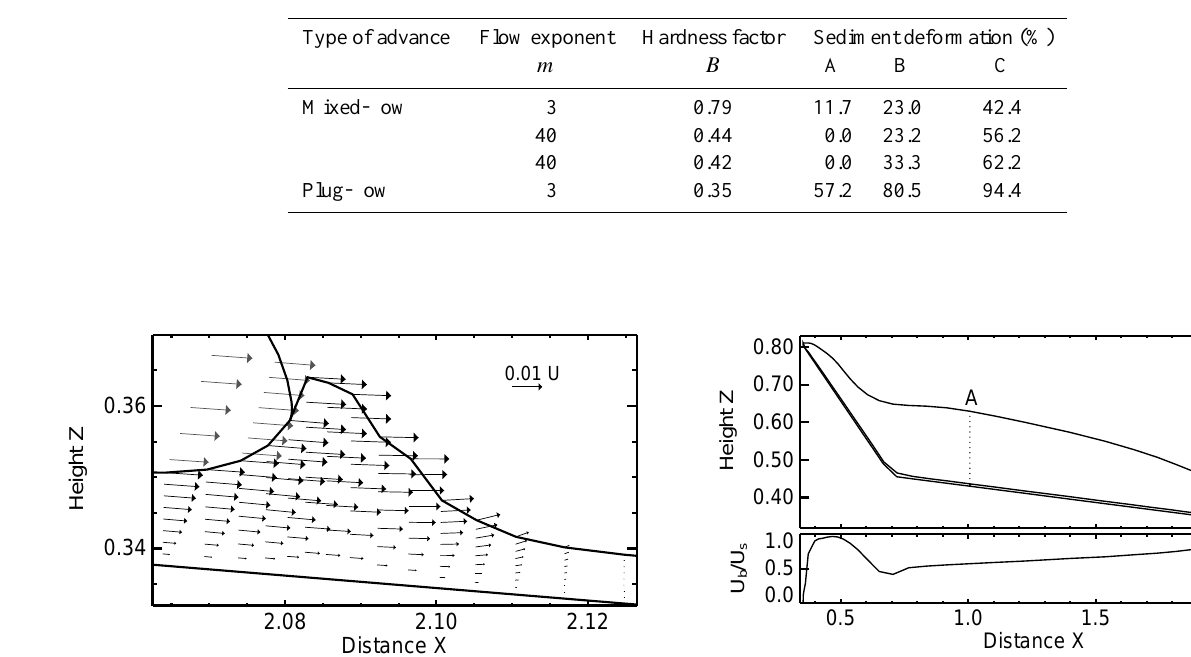
Table 2. Contribution of sediment deformation at positions A, B, C in percentage to the total deformation.